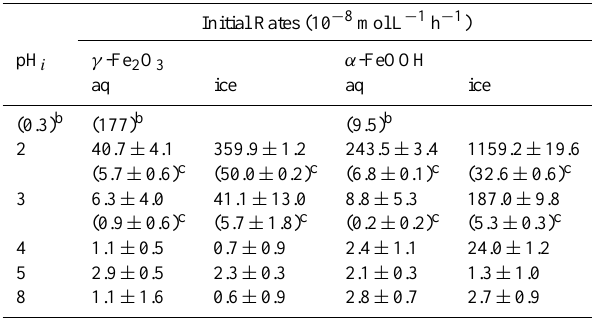
Table 3. Initial dissolution rates of different iron oxides at various pH in the absence of organic ligand a .